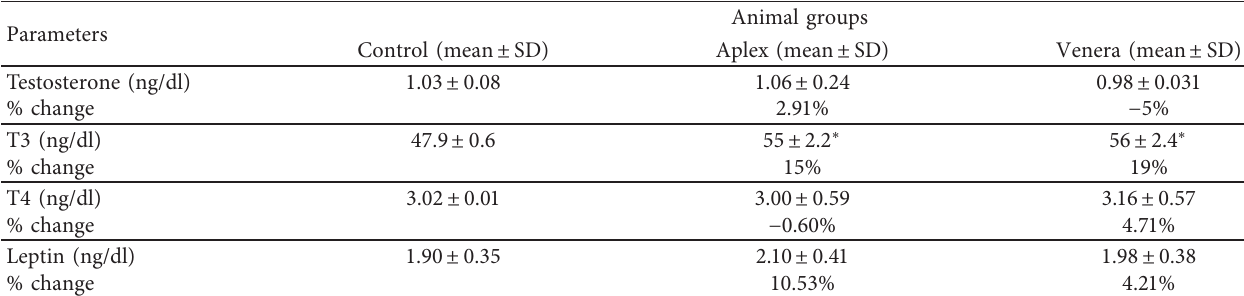
Table 7: Levels of testosterone, T3, T4, and leptin in sera of control and treated animal groups.